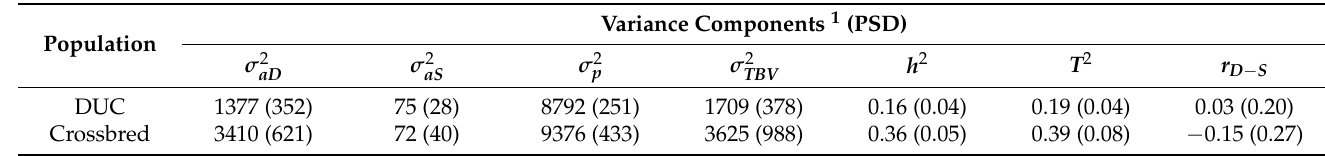
Table 1. Estimates of variance components (posterior standard deviations, PSD) in purebred Korean Duroc (DUC) and crossbred pigs.